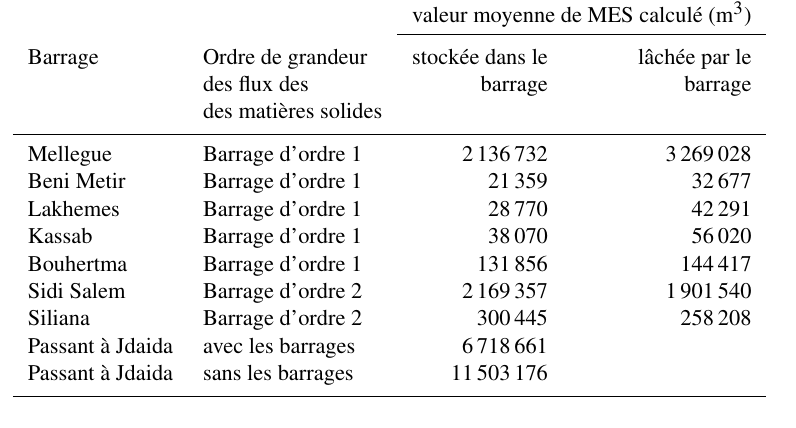
Tableau 2. Rapport sur valeur moyenne de MES calculé au niveau de chaque barrage et des valeurs moyennes de MES calculées à Jdaida.